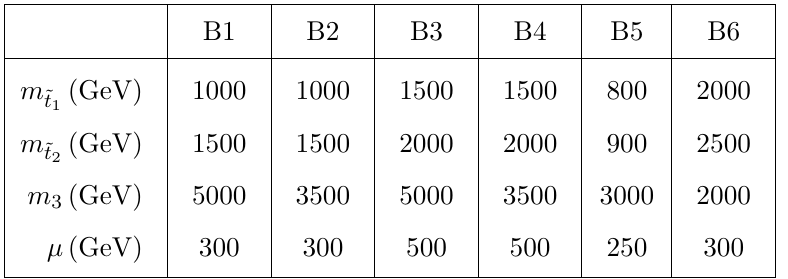
Table 2. Benchmarks for quantitative investigation of sgluon decay and production.